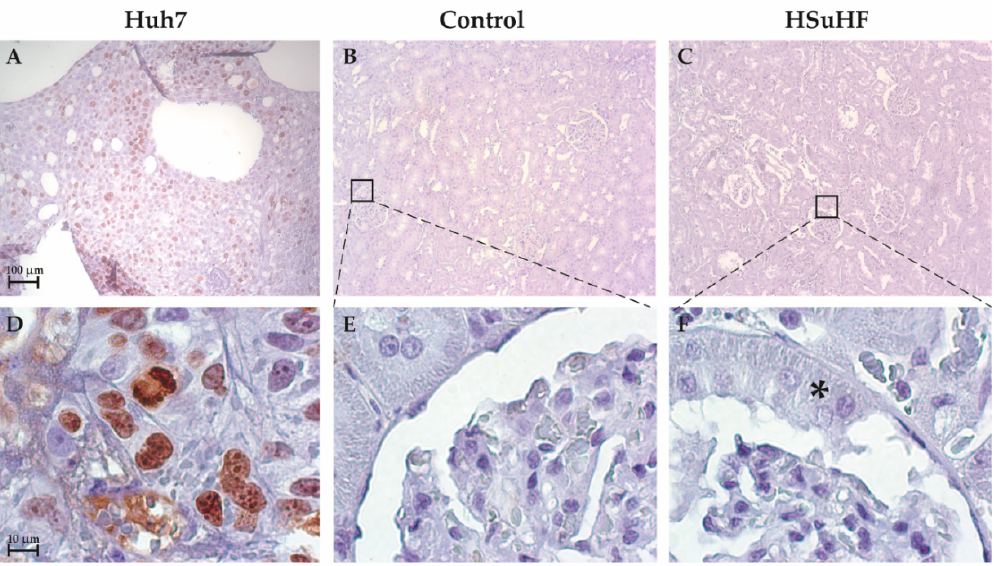
Figure 3. Representative confocal images of immunolabelling for collagen IV (green: B and E), DAPI (blue: A and D), as well as merge (C and F) in the Control and HSuHF-treated rats ( n = 8 per group).